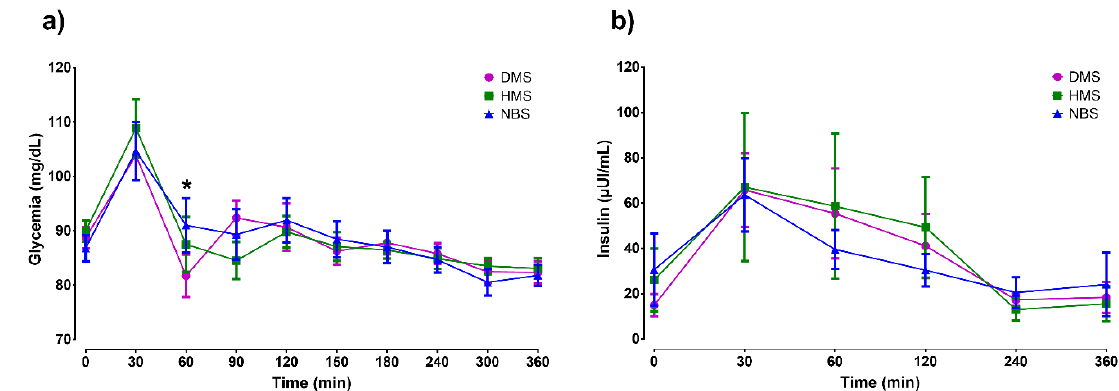
Figure 2. Postprandial responses of (a) glycemia and (b) insulin. The basal concentrations and the concentrations following ingestion of breakfast and treatments are shown. Data are expressed as mean ± SEM ( n = 14). Comparisons are based on two-way repeated-measures ANOVA and the Tukey post-hoc test. * p < 0.01, NBS vs. DMS.